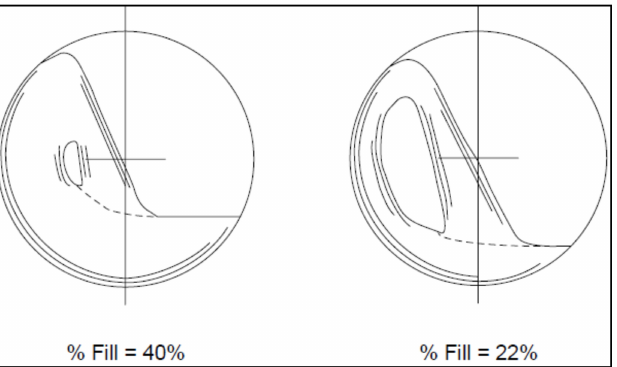
Figure 6. Illustration of the difference in load behaviour for different ball charge levels but rotating at the same mill speed (after